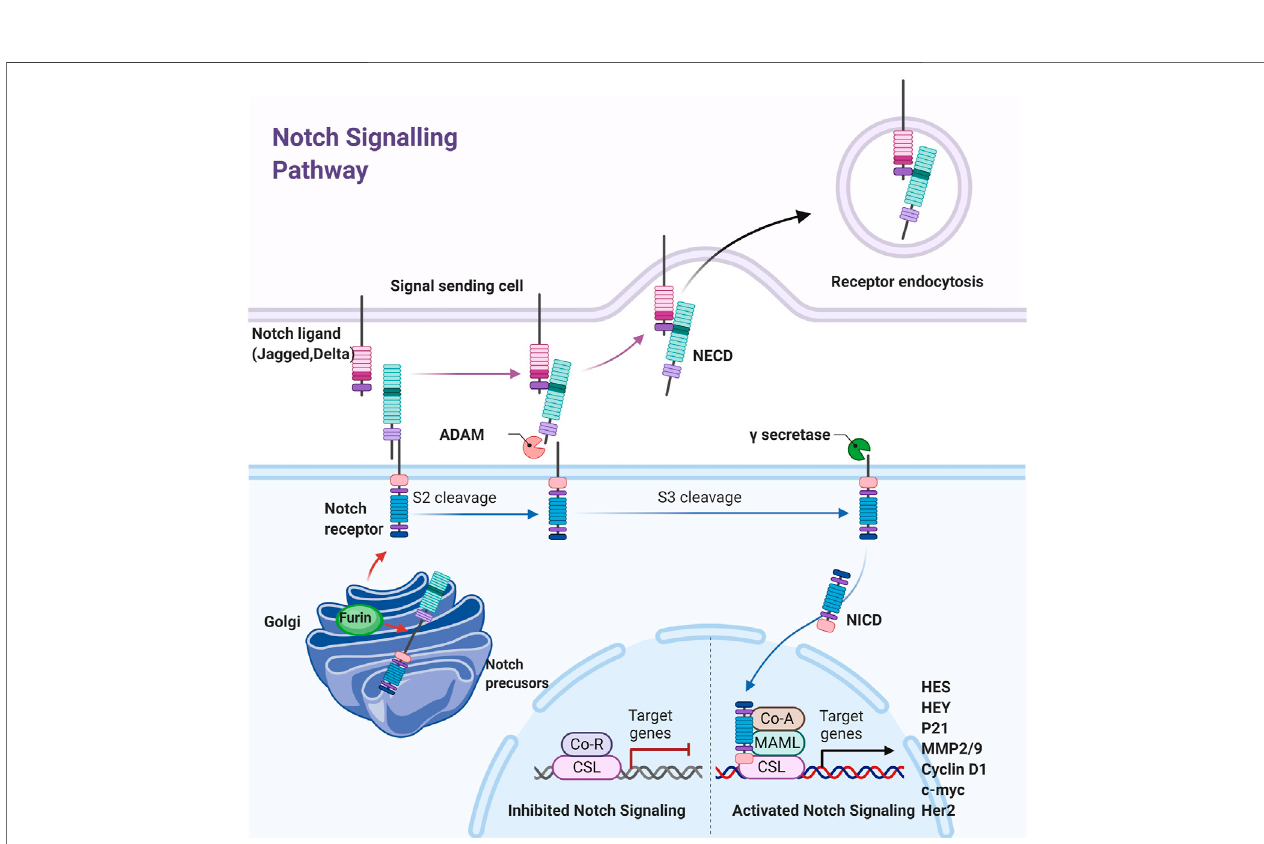
Frontiers in Pharmacology |